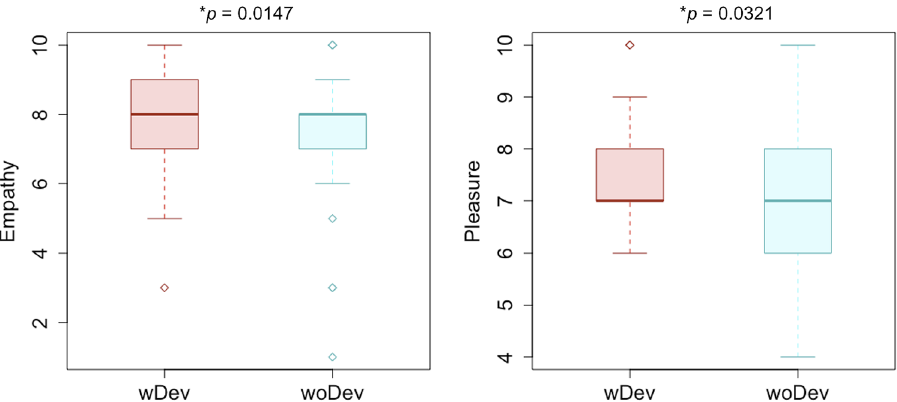
Figure 2. Empathy and pleasure of chills per conditions: participants wearing the device reported experiencing significantly greater emotional contagion and more pleasure during the experience with the device than during the experience without the